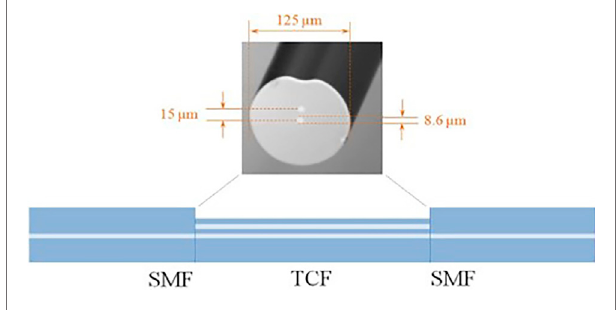
FIGURE 4 | Schematic of the TCF salinity sensor [32].